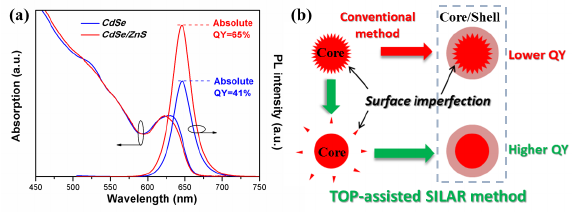
Figure 2: (a) Absorption and PL spectra of as-prepared CdSe (blue line) and CdSe/ZnS (red line). (b) Schematic of the TOP-assisted SILAR method. PL: photoluminescence; TOP: tri-n-octylphosphine; SILAR: successive ionic layer adsorption and reaction.